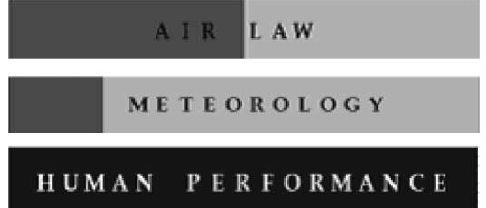
Figure 1. Example of Flight Club’s skill